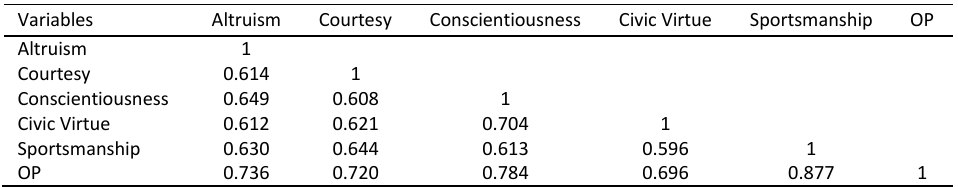
Table 2: The results of Pearson correlation